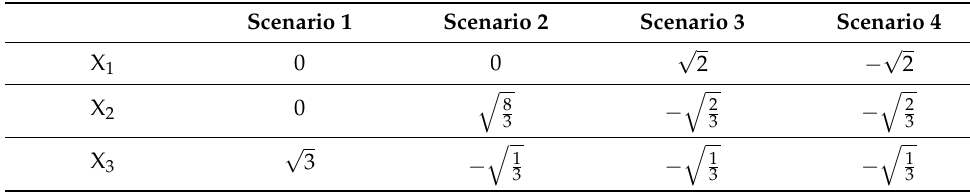
Table 1. Variable values for X 1 , X 2 , and X 3 in in the predefined scenarios. Scenario 1 Scenario 2 Scenario 3 Scenario